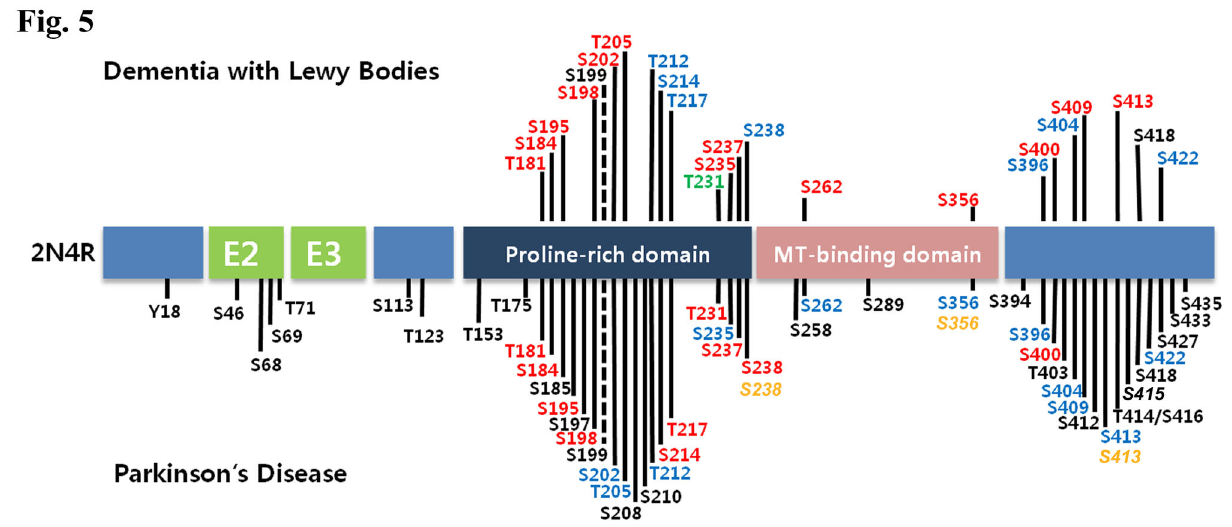
Figure 5. Schematic of Tau phosphorylation in PD, DLB, and AD. Full length Tau [2N4R] contains ~45 known Thr/Ser sites known to be hyperphosphorylated in AD. These sites are spread throughout several regions of Tau, including the E2/E3 domains, the proline-rich domain, the MT-binding domain, and the C-terminal of the Tau protein. Phosphorylation at 20 sites [Table S1 in File S1] was analyzed in PD striata [bottom] and DLB FC [top]. Sites with elevated phosphorylation are indicated in red, while sites where phosphorylation was similar to controls are indicated in blue. A decrease in phosphorylation at T231 was identified in DLB tissues [green]. Sites in orange represent hyperphosphorylated sites present in DLB FC. Sites in black denote epitopes not tested in PD or DLB or AC. All sites shown, regardless of color, are hyperphosphorylated in AD. doi: